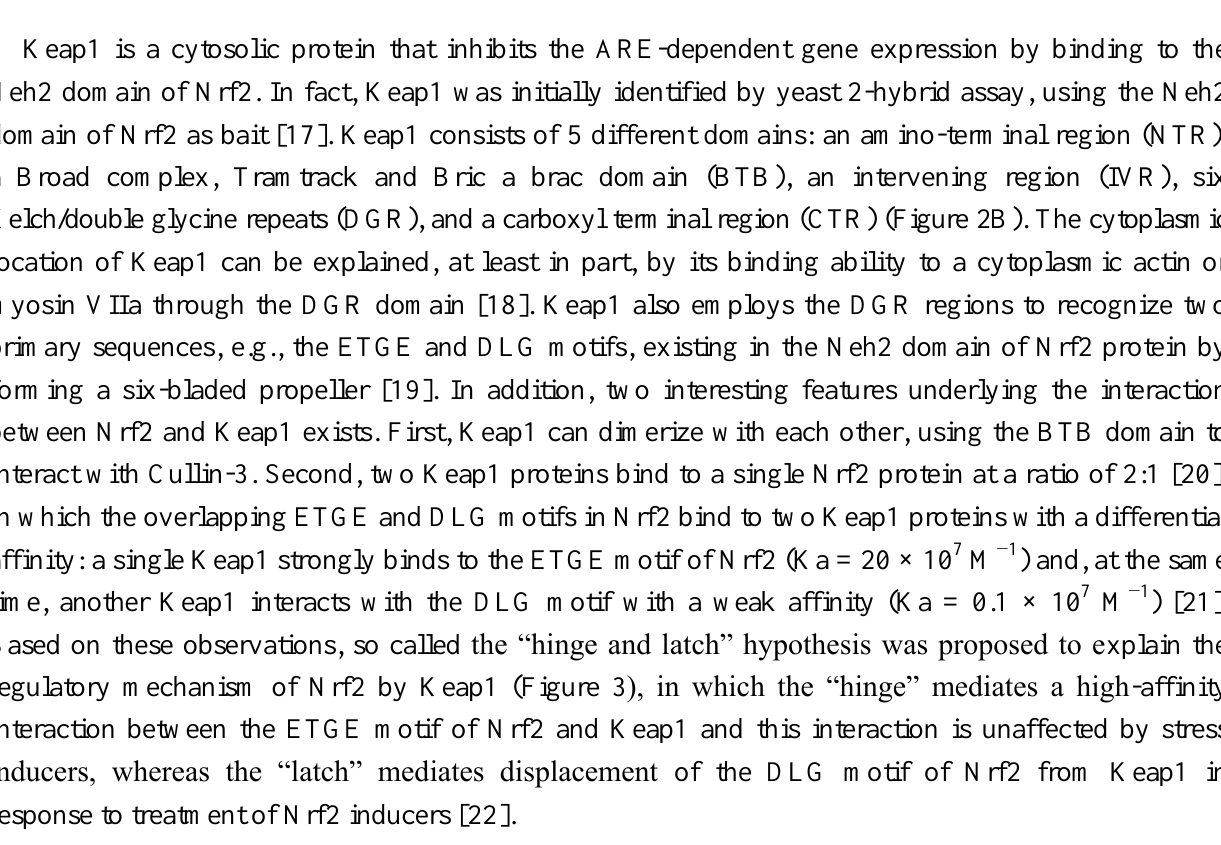
Figure 3. The “Hinge and Latch” Hypothesis. Under basal conditions, Keap1 forms a homodimer and associates with Cullin-3 protein. At the same time, the DGR domains